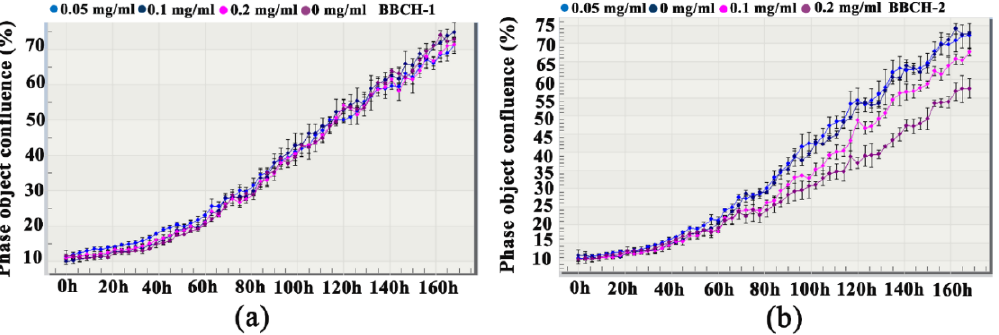
Figure 1. BBCH-1 and BBCH-2 fractions stimulated the proliferation of MC3T3-E1 cells. ( a , b ) MC3T3-E1 growth curves after treatment with BBCH-1 and BBCH-2, respectively. The y-axis is a label-free measure of cell confluence utilized by IncuCyte ZOOM live cell imaging system to evaluate cell proliferation. BBCH, bovine bone collagen hydrolysate.